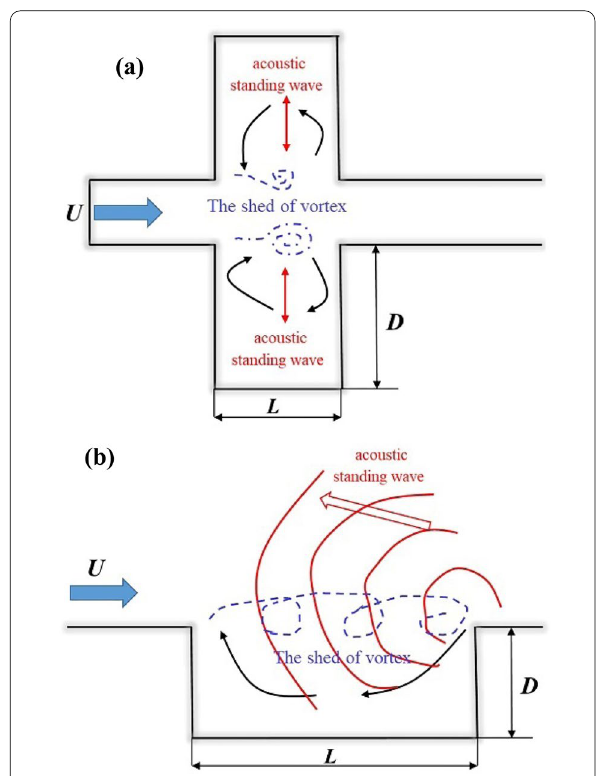
Figure 1 Schematic diagram of cavity flow oscillations: ( a ) deep cavity, ( b ) shallow